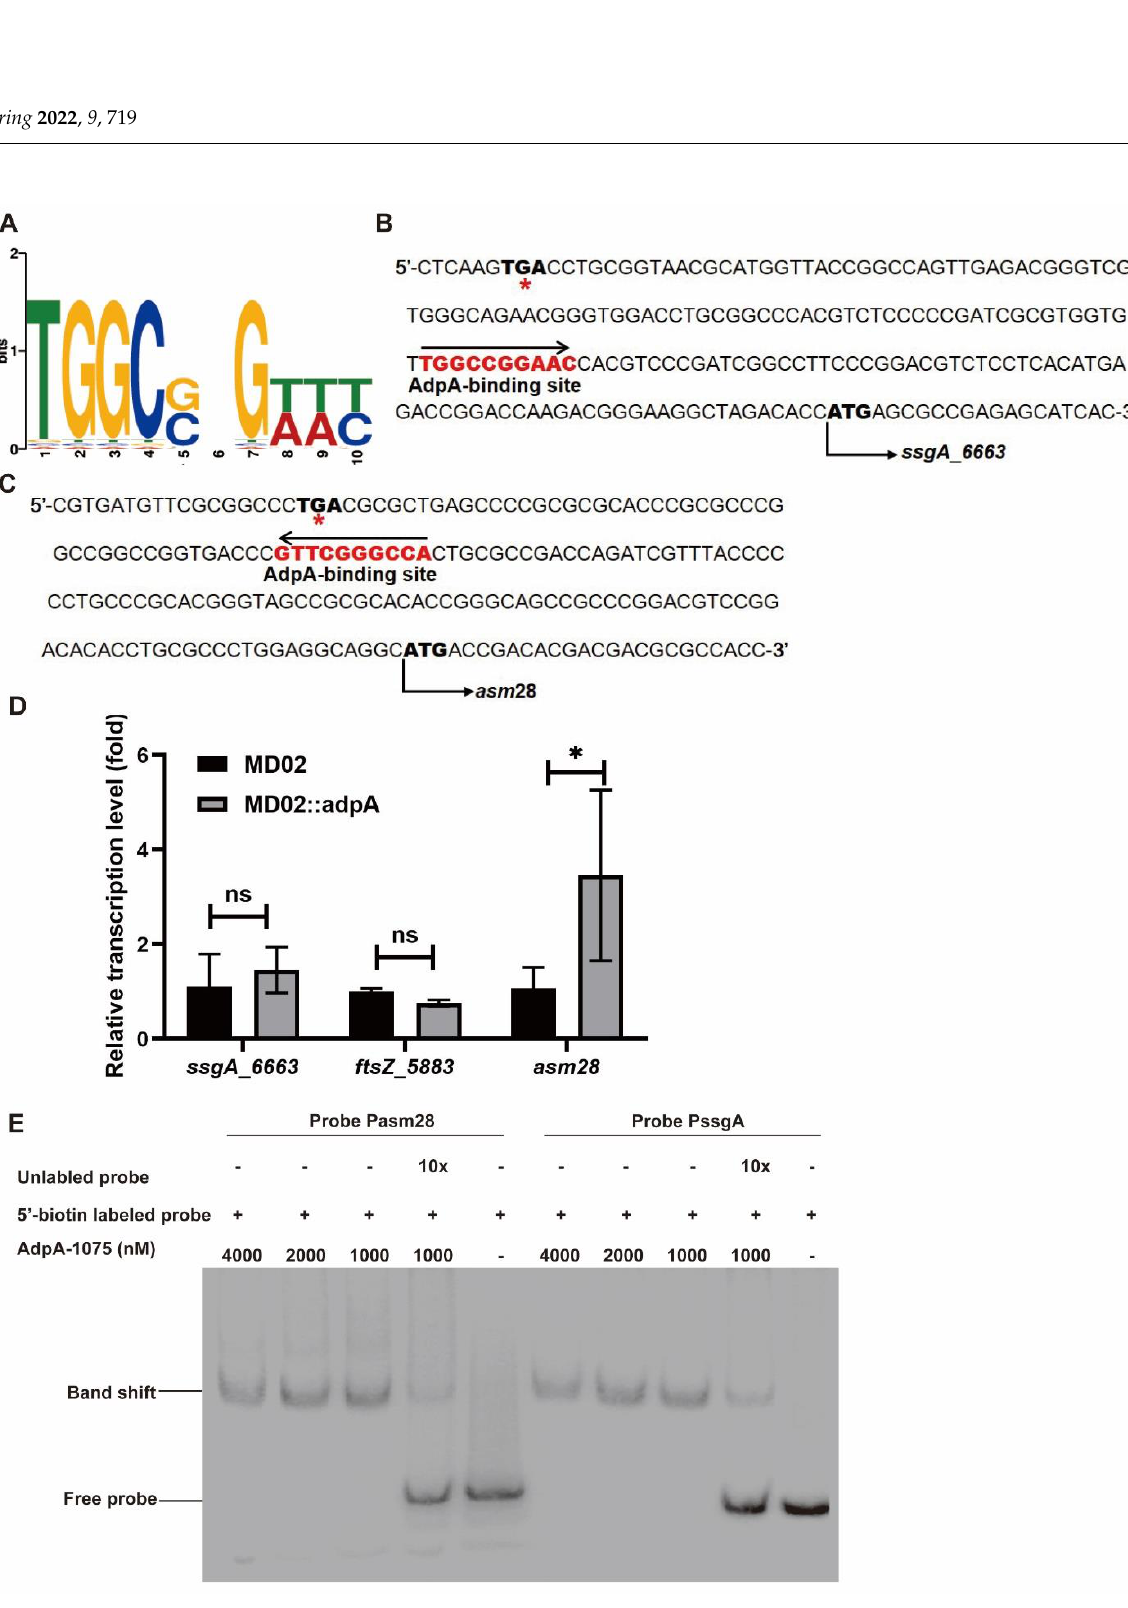
Figure 5. AdpA_1075 binds PssgA and Pasm28. ( A ) The Sequence of AdpA-binding motif. ( B , C ) Conserved (shown in red) AdpA-binding motifs in the upstream region of ssgA _ 6663 and asm28 . The start codon of ssgA _ 6663 or asm28 are shown in bold black. *, stop codons. ( D ) Relative transcription of gene ssgA_6663 , ftsZ_5883 , asm28 in mutant with adpA_1075 overexpression on day 3 of fermentation. Gene expression level was determined by 2 − ∆∆ Ct method. The average expression value of genes in the strain MD02 was set to 1 as the standard, and the values are means ± SD of triplicate analyses. Differences were analyzed by one-way ANOVA, ns, no significant, *, p < 0.05. ( E ) EMSAs of purified AdpA_1075-His 6 binding to the probes PssgA and Pasm28 labeled with biotin in the upstream region of ssgA_6663 and asm28 . 20 ng biotin-labeled probes were incubated for 10 min at room temperature. The experiment was repeated for three times.